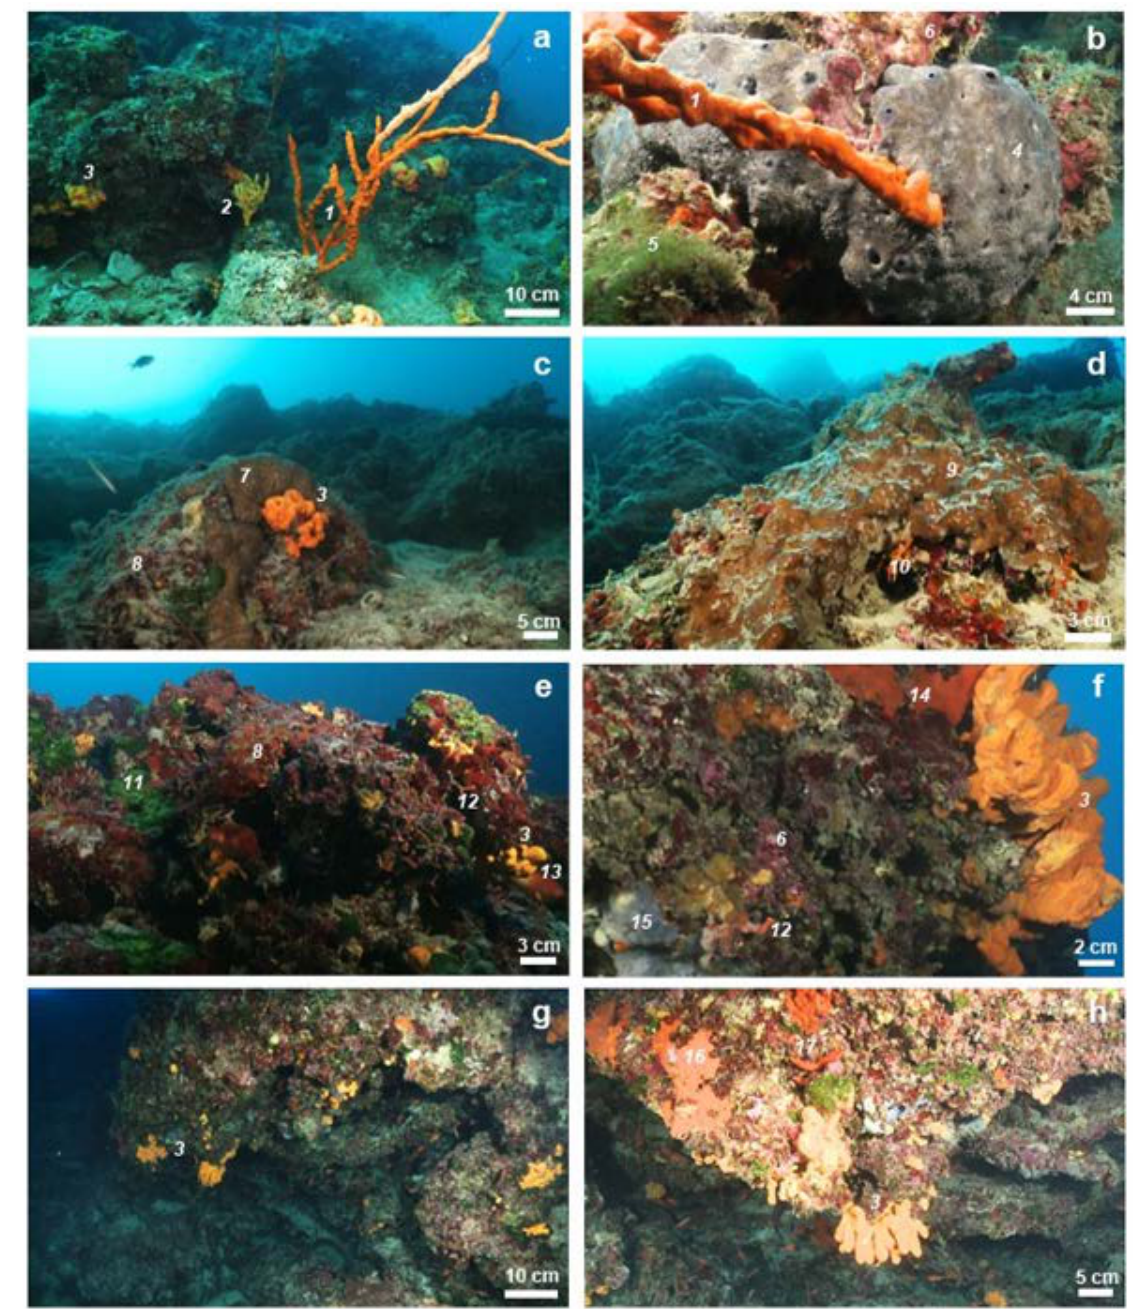
Figure 5. Images of benthic assemblages from the coralligenous formations in the study areas: ( a , b ) Zhapovel Bay (ZH), ( c , d ) Cape of Dhim Kushta (DH), ( e , f ) Haxhi Ali Cave (HA), and ( g , h ) Cape of Gjuhezes (WE). The most conspicuous species present are marked as follows: 1. Axinella cannabina , 2. A. polypoides , 3. Agelas oroides , 4. Sarcotragus foetidus , 5. algal turf, 6. Encrusting Coralline Rodo- phyta (ECR), 7. Chondrosia reniformis , 8. Peyssonnelia sp., 9 . Cliona copiosa, 10. Pentapora fascialis , 11. Palmophyllum crassum , 12. Myriapora truncata , 13. Halocynthia papillosa , 14. Crambe crambe , 15. Phorbas tenacior , 16. undetermined Spirastrellidae, and 17. Hacelia attenuata.